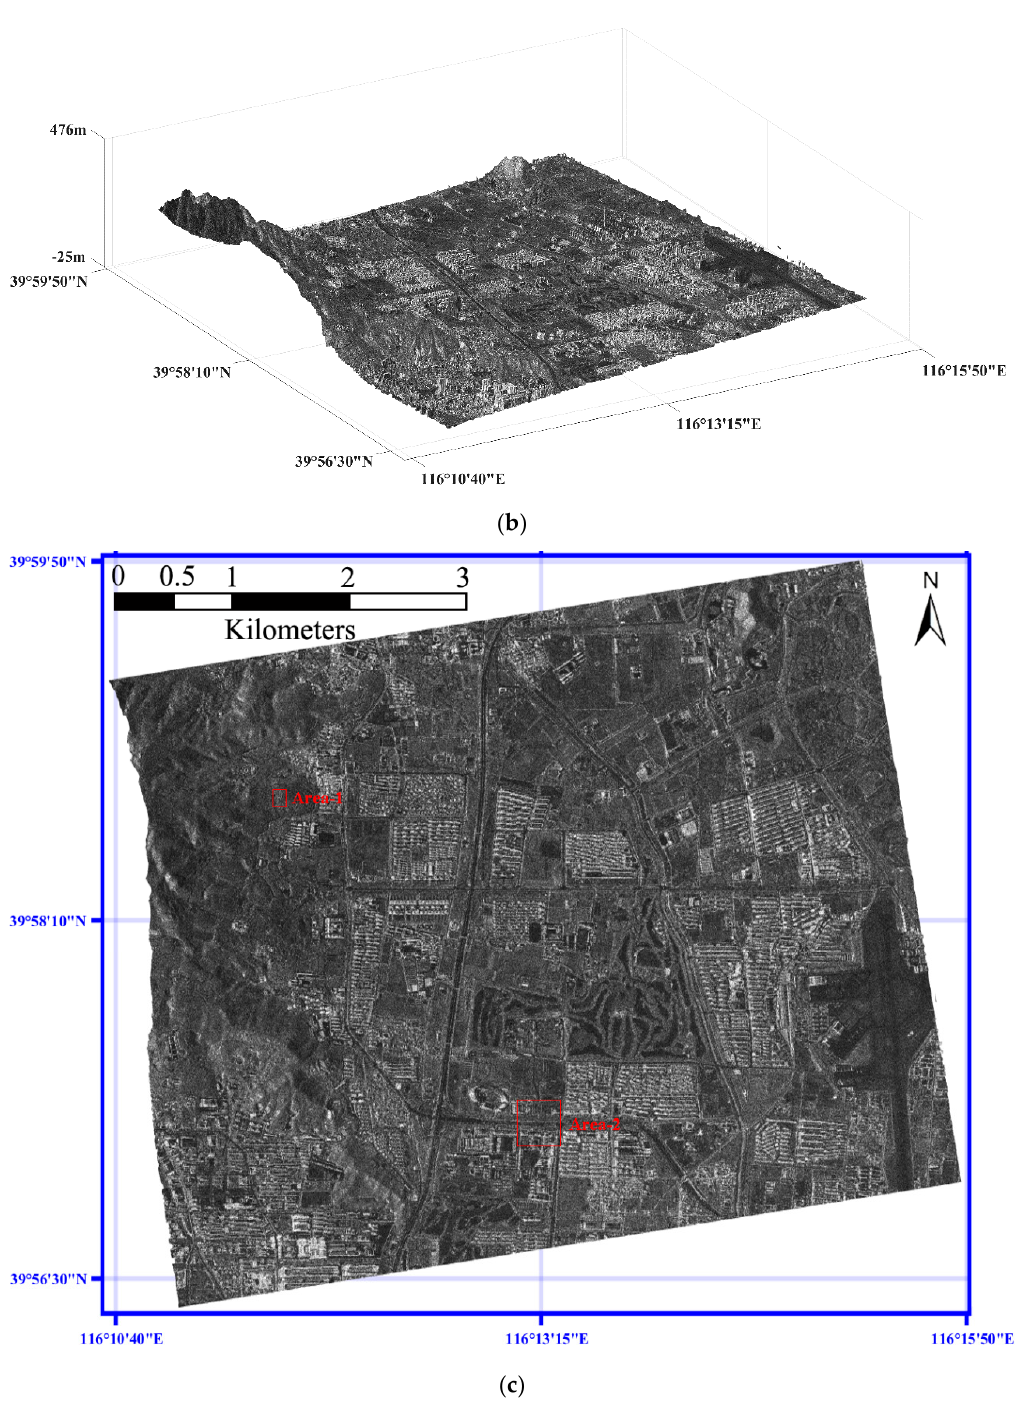
Figure 6. The TanDEM-X SAR image geolocation results (M2). ( a ) DSM. ( b ) The three-dimensional image. ( c ) The two-dimensional image.